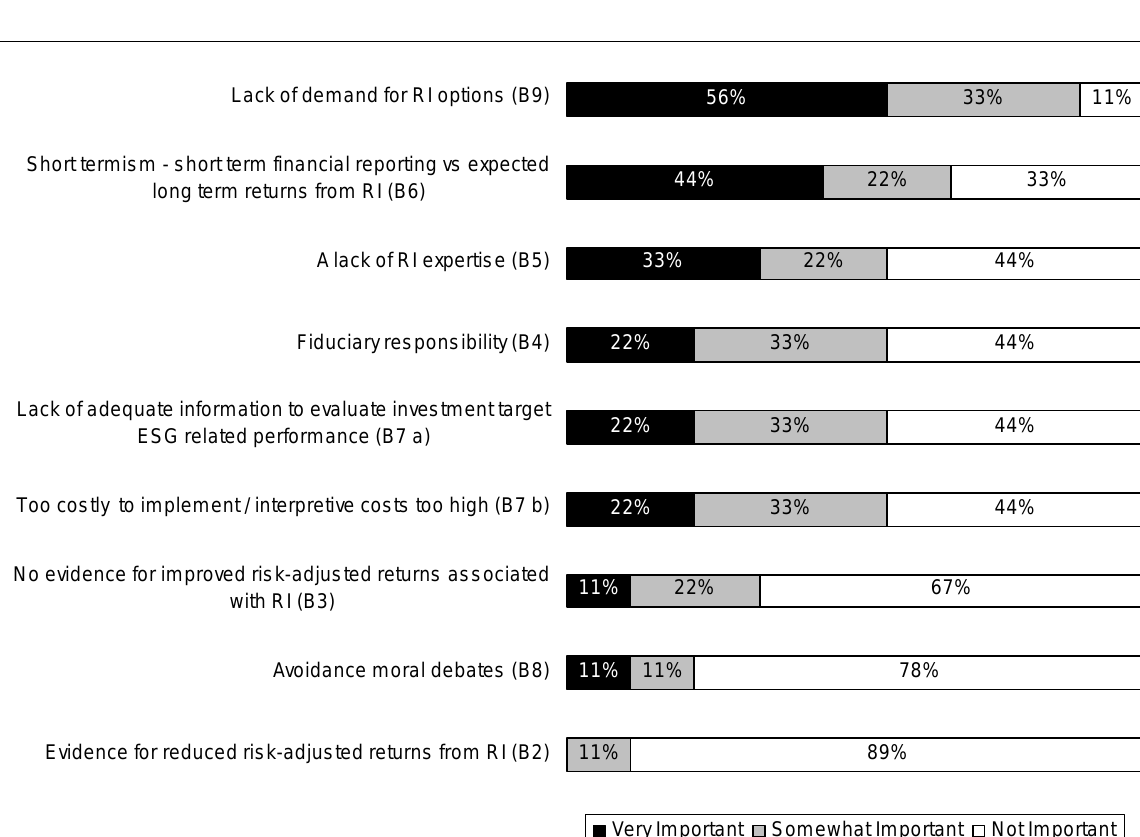
Figure 2: Asset managers - Barriers to RI